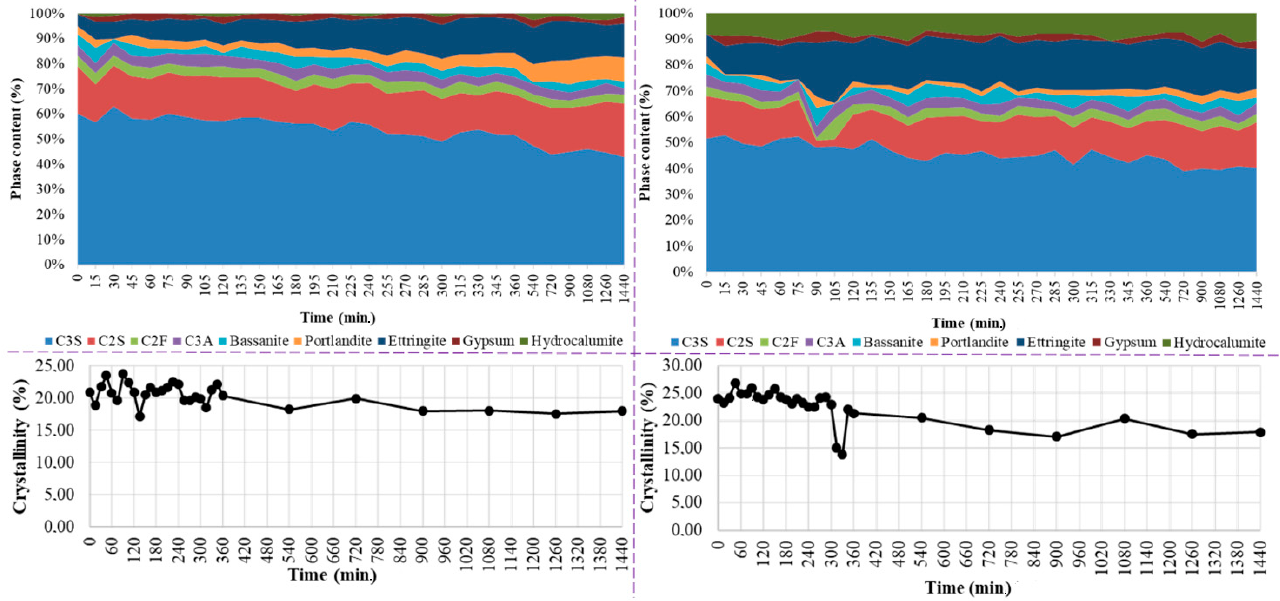
Figure 6. Phase analysis ( up ) and degree of crystallinity ( down ) of the C0 ( left ) and C45 ( right ) samples, from t 0 up to 24 h.